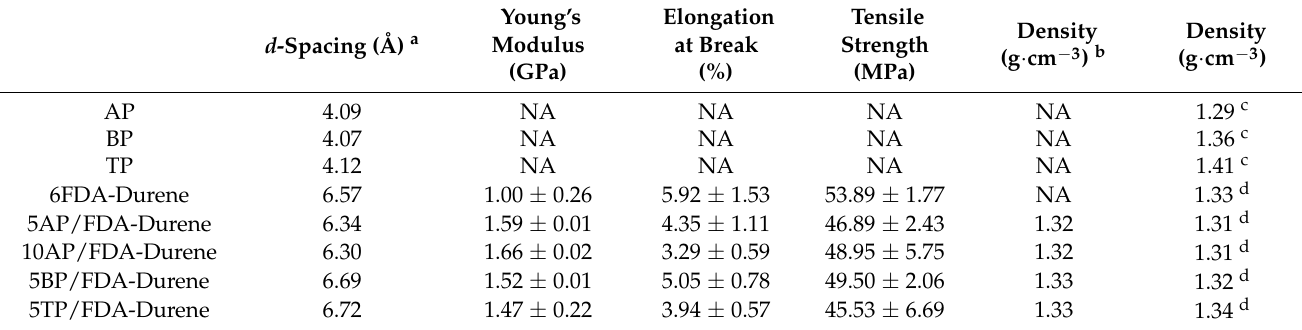
Table 2. Physical properties of continuous phase and dispersed phase.